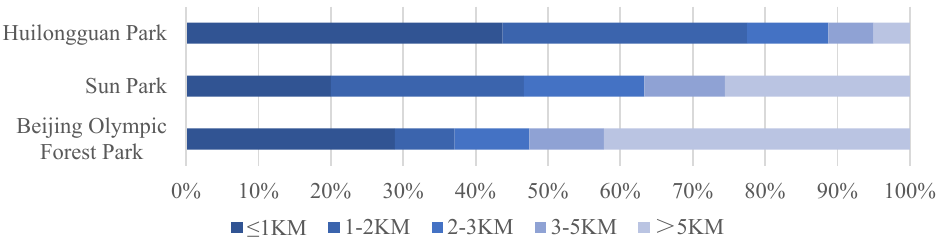
Figure 4. The distance from the users’ residences to the sports park.